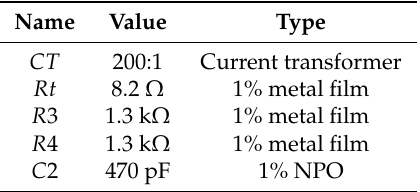
Table 2. Component values for the load current conditioning